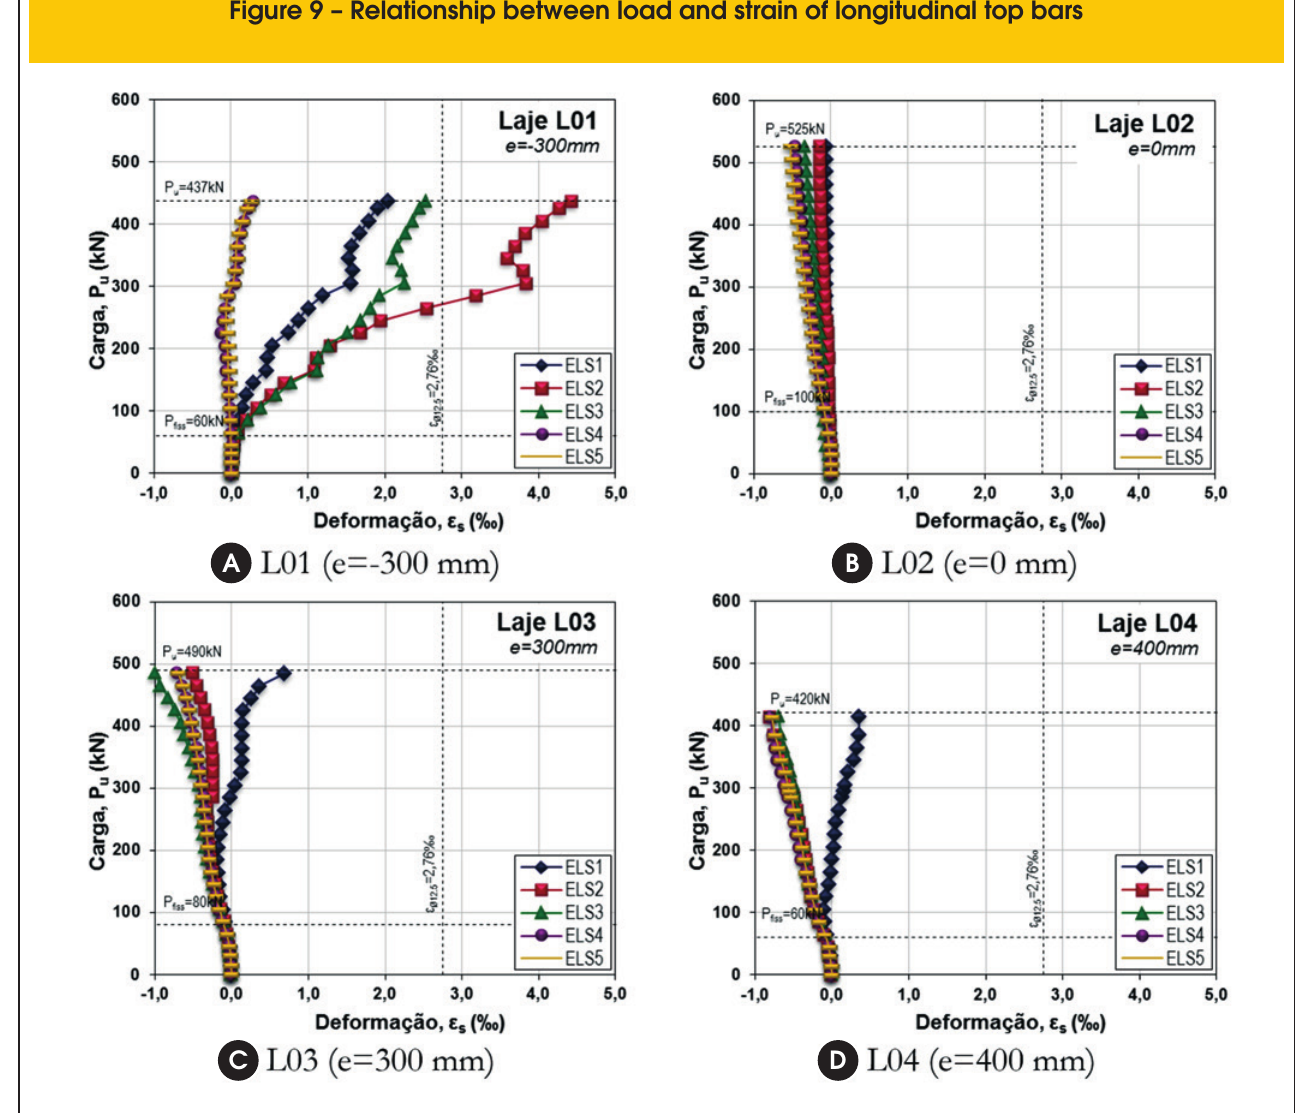
Figure 9 – Relationship between load and strain of longitudinal top